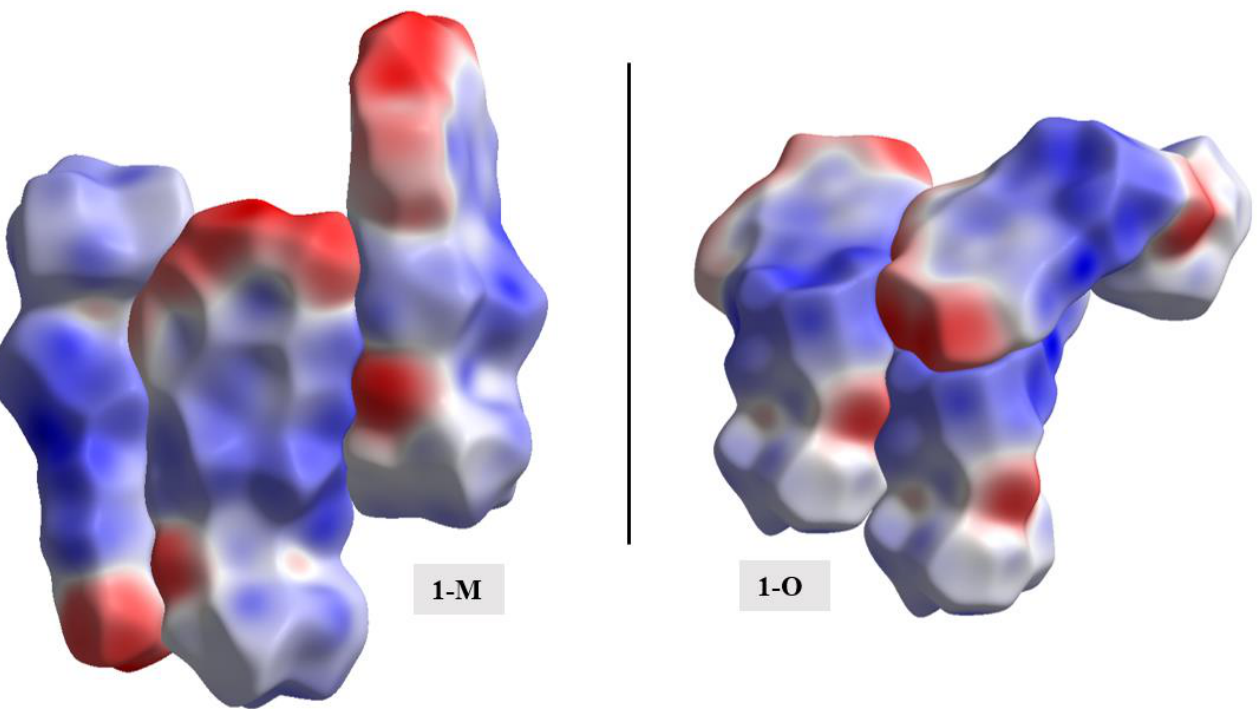
Figure 18. The calculated electrostatic potential maps for 1 - M and 1-O . A cutaway of the surface is shown for clarity.